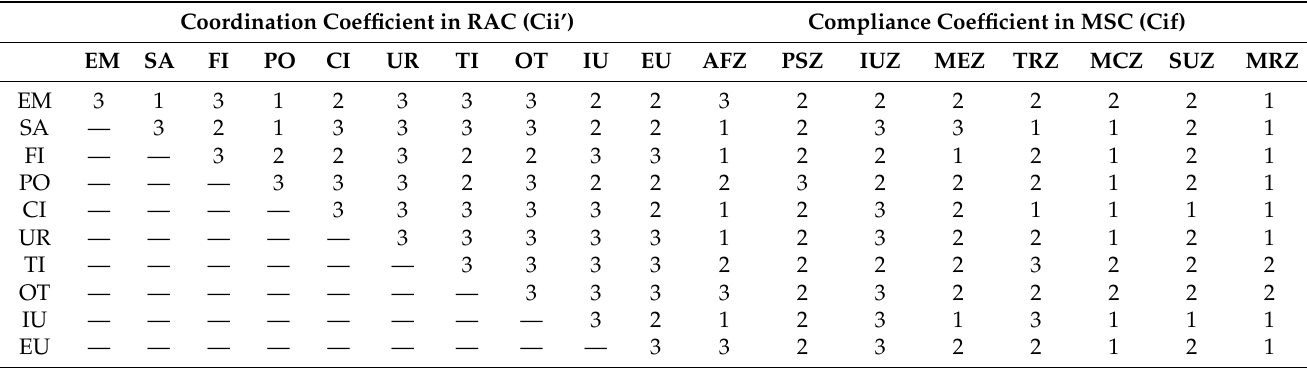
Table 3. Coordination and compliance coefficient of reclamation and marine spatial planning zones. Coordination Coefficient in RAC